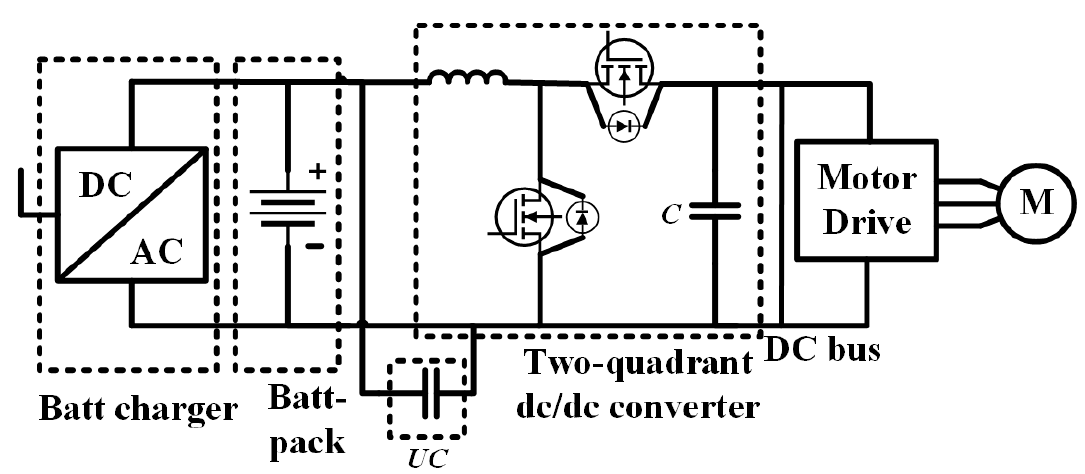
Figure 51. Converter placement in a pure EV [35]. The charger has an AC-DC converter to supply DC to the battery from the grid, whereas the DC-DC converter converts the battery voltage into a value required to drive the motor.